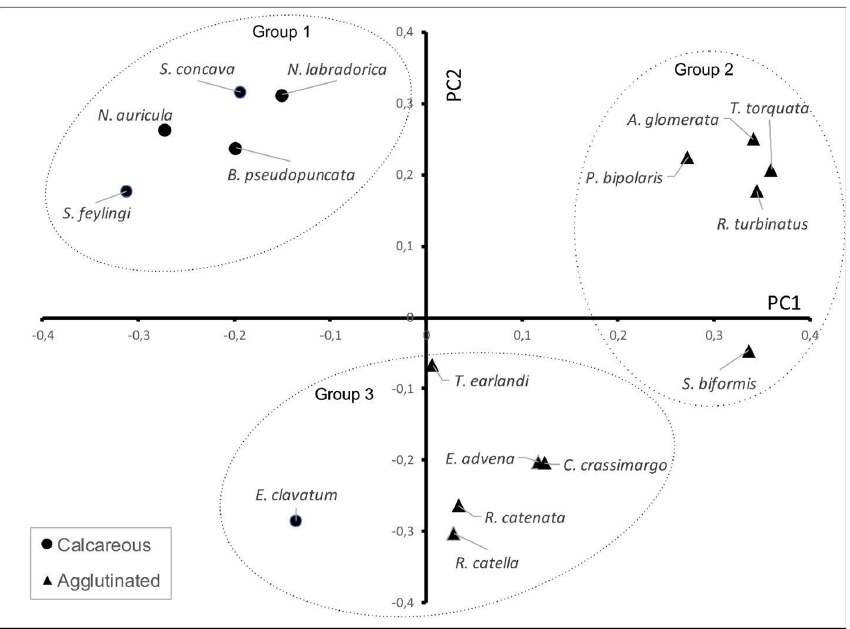
Figure 6. Loadings plot resulting from the principal component analysis of the foraminiferal assemblages in POR13-05. PC1 and PC2 explain 28.6% and 16.8% of the variance, respectively. Only species representing > 0 . 5% of the total amount of counted tests were taken into account for PCA